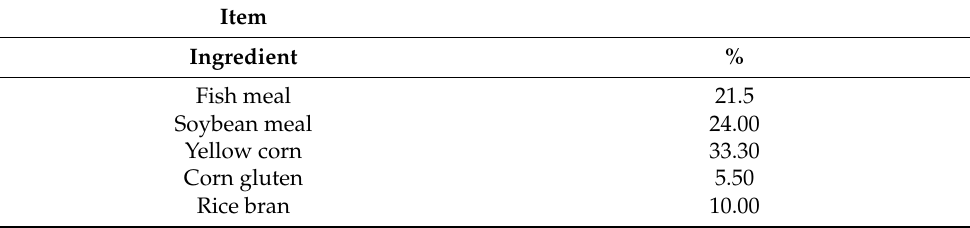
Table 1. Ingredients and chemical composition of the basal